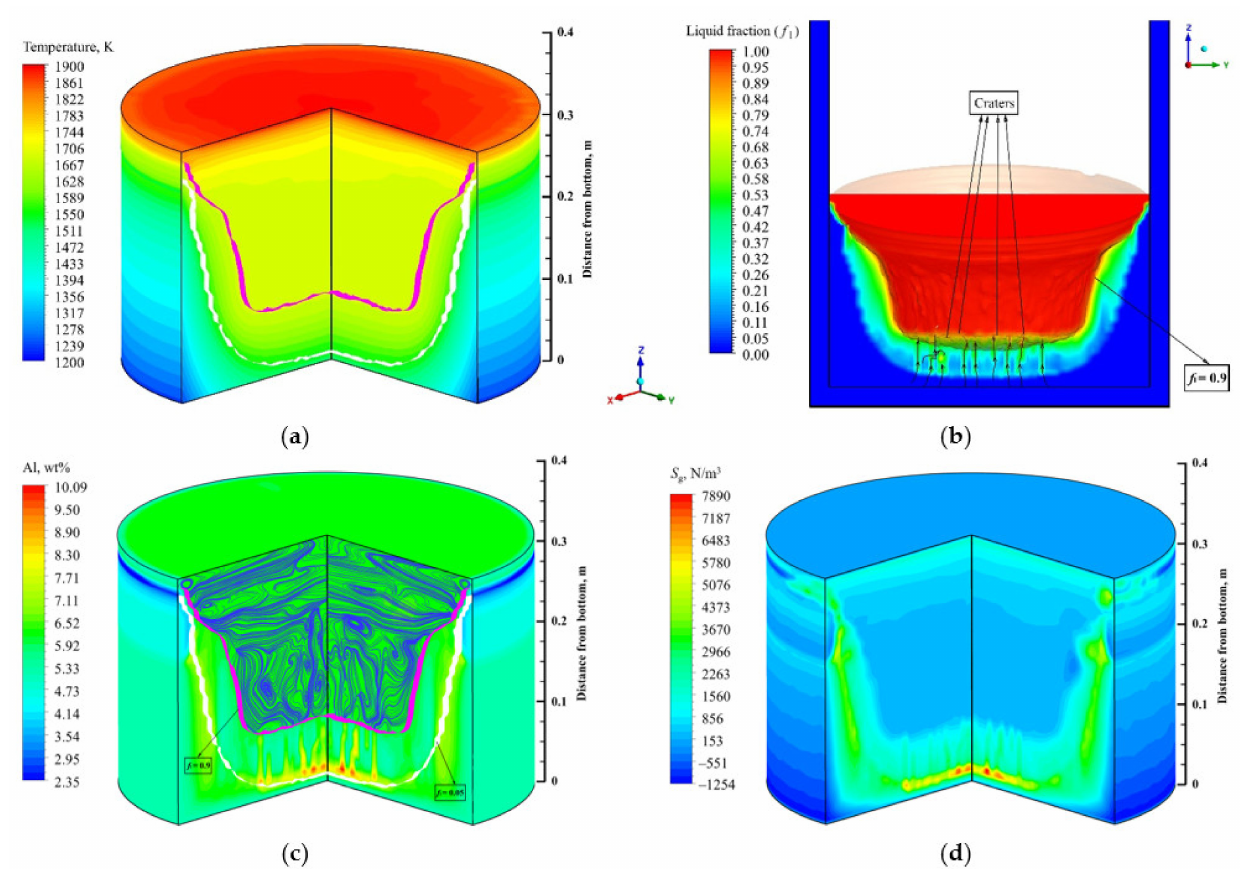
Figure 9. Results at solidification time t = 1500 s: ( a ) temperature distribution; ( b ) velocity field in the channels and liquid fraction at X = 0; ( c ) streamlines and solute distribution; ( d ) thermosolutal